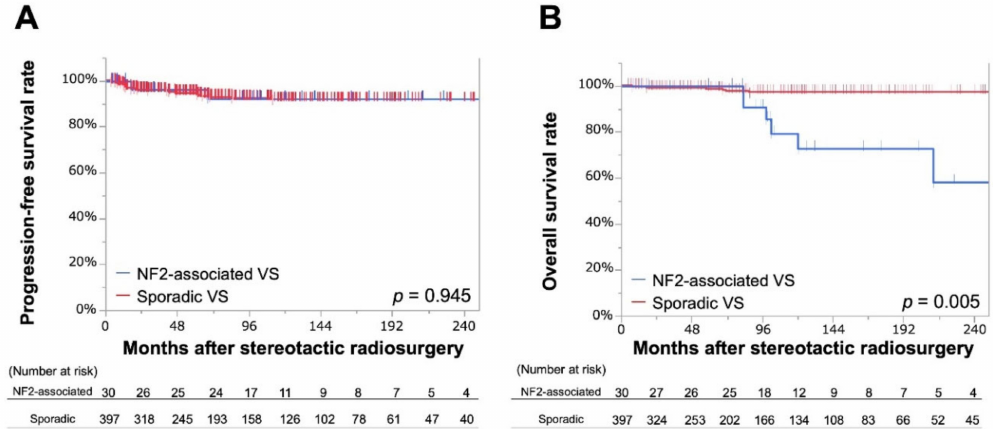
Figure 1. Kaplan–Meier curves for the progression-free survival rate ( A ) and overall survival rate ( B ) before matching comparing neurofibromatosis type 2-associated vestibular schwannoma with sporadic vestibular schwannoma. NF2 = neurofibromatosis type 2; OS = overall survival rate; PFR = progression-free rate; VS = vestibular schwannoma. Table 2. Results of bi- and multivariate analyses of tumor progression before matching. * Values of p < 0.05 are considered statistically significant. HR = hazard ratio; CI = confidence interval; NF2 = neurofibromatosis type 2; SRS = stereotactic radiosurgery; Gy = gray. Bivariate Multivariate Variables p Value HR (95%CI) p Value